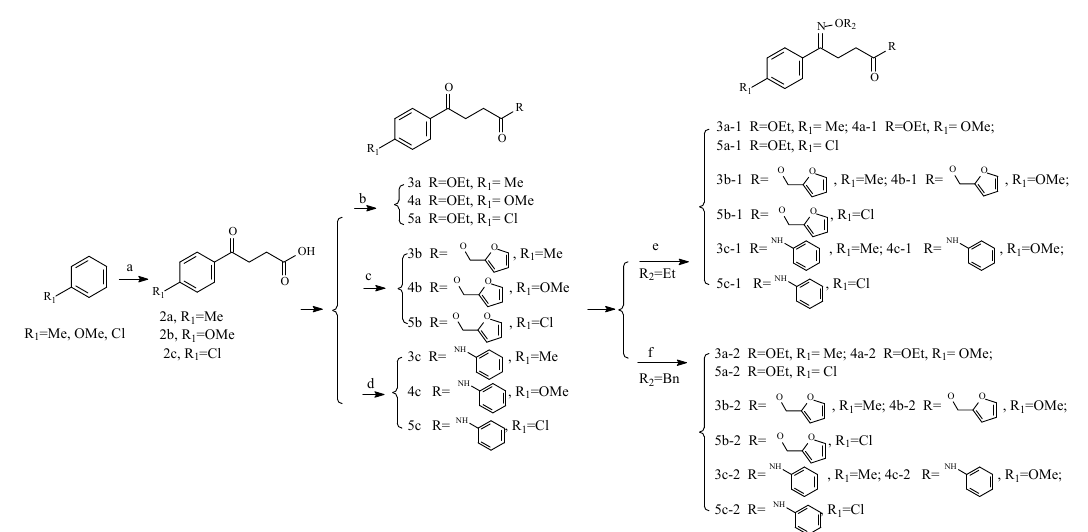
Scheme 1. Synthetic route of the series of compounds. Reagents and conditions: (a) succinic anhydride, AlCl 3 /DCM, overnight, r.t.; (b) TsOH/EtOH, refiux, 6–8 h; (c) Furfuryl alcohol, DMAP, DCC/THF, 0.5 h 0 ◦ C; 6–8 h, r.t.; (d) Aniline, DMAP, DCC/THF, 0.5 h 0 ◦ C; 6–8 h, r.t.; (e) NH 2 OCH 3 · HCl, Pyridine/DCM, 70 ◦ C, 6–7 h; (f) NH 2 OCH 2 C 6 H 5 · HCl, Pyridine/DCM, 70 ◦ C, 6–7.